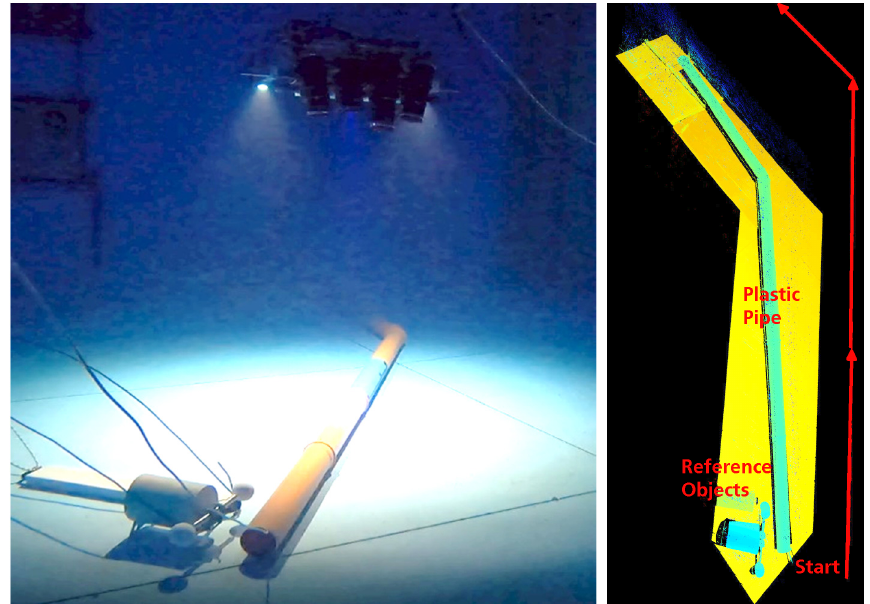
Figure 8. Photograph of the sensor, pipe, and specimen ( left ) and false-color representation of the modeling result after merging of the continuously recorded 3D data sets ( right ).